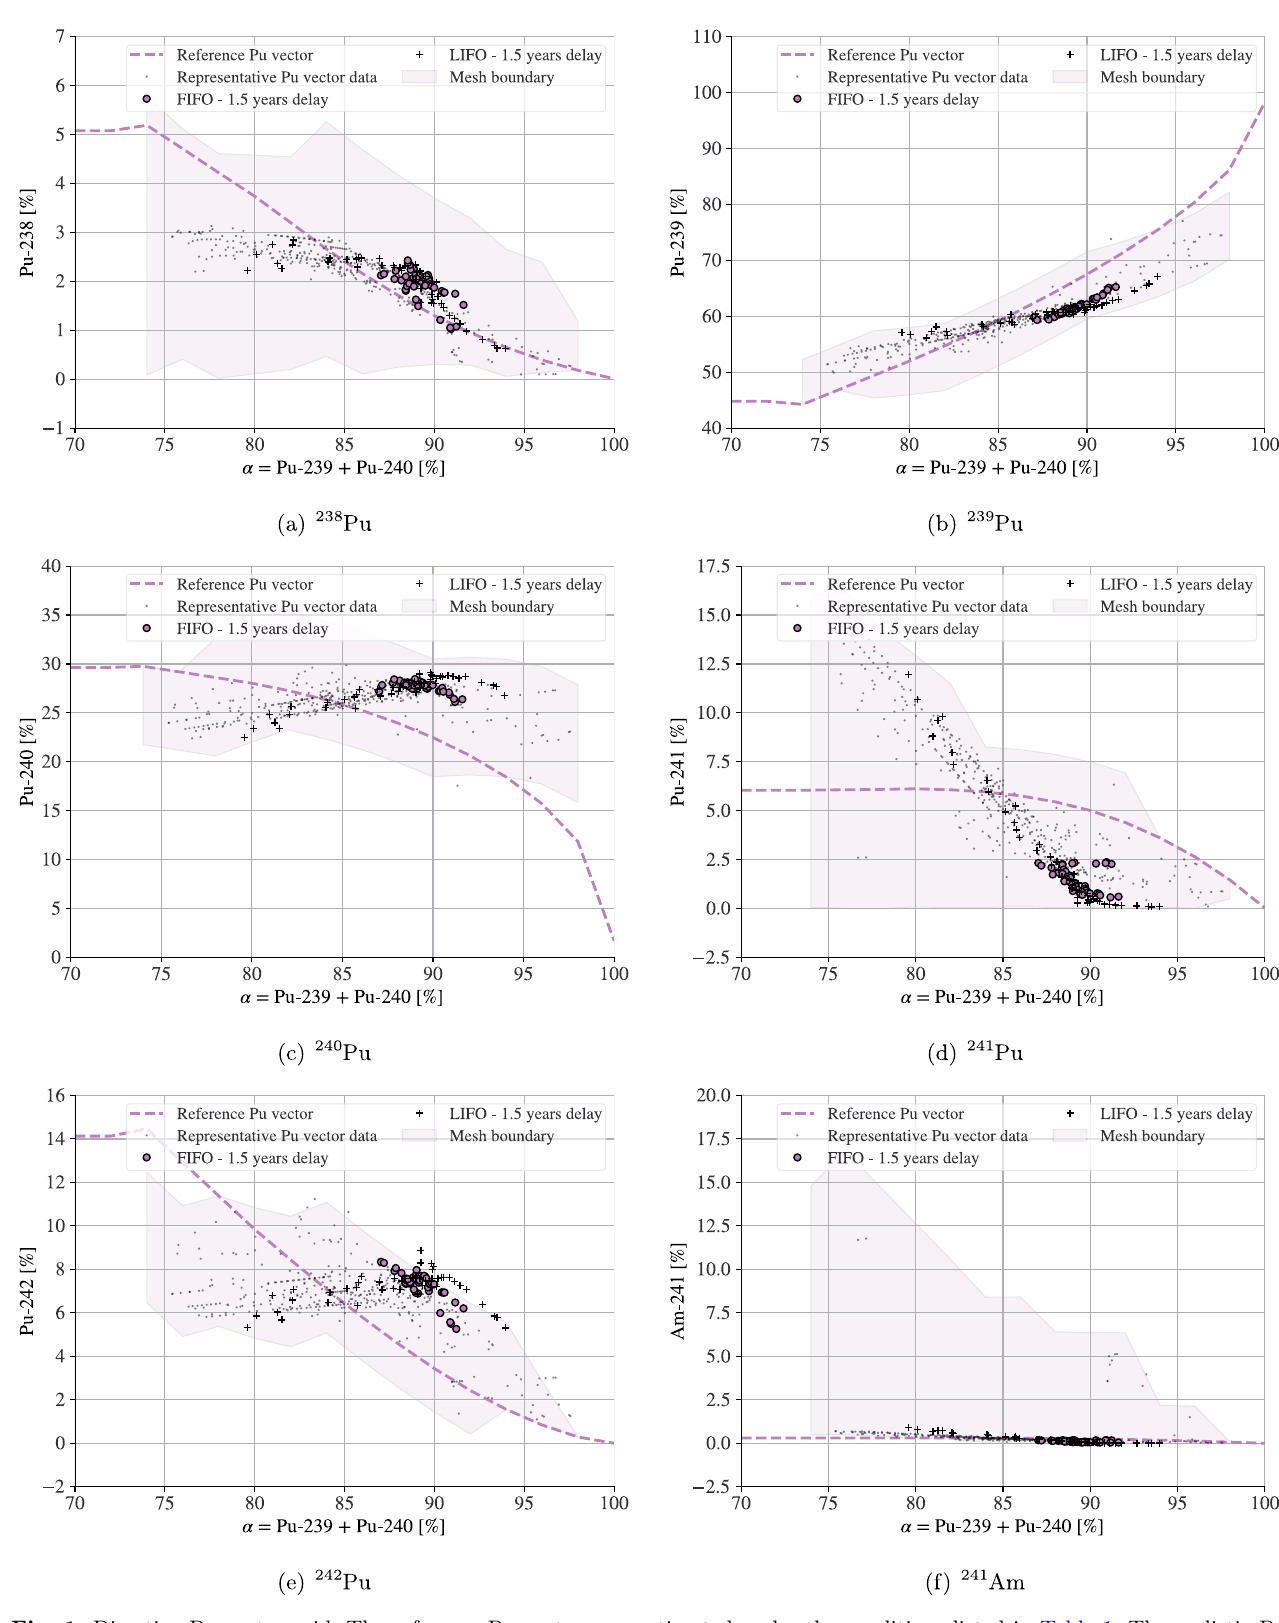
Fig. 1. Directive Pu vector grid. The reference Pu vectors are estimated under the conditions listed in Table 1. The realistic Pu vector data is used to outline the grid boundaries of the directive Pu vector grid. The FIFO and LIFO scenarios with 1.5 years of delay between reprocessing and core reload are further discussed in Section